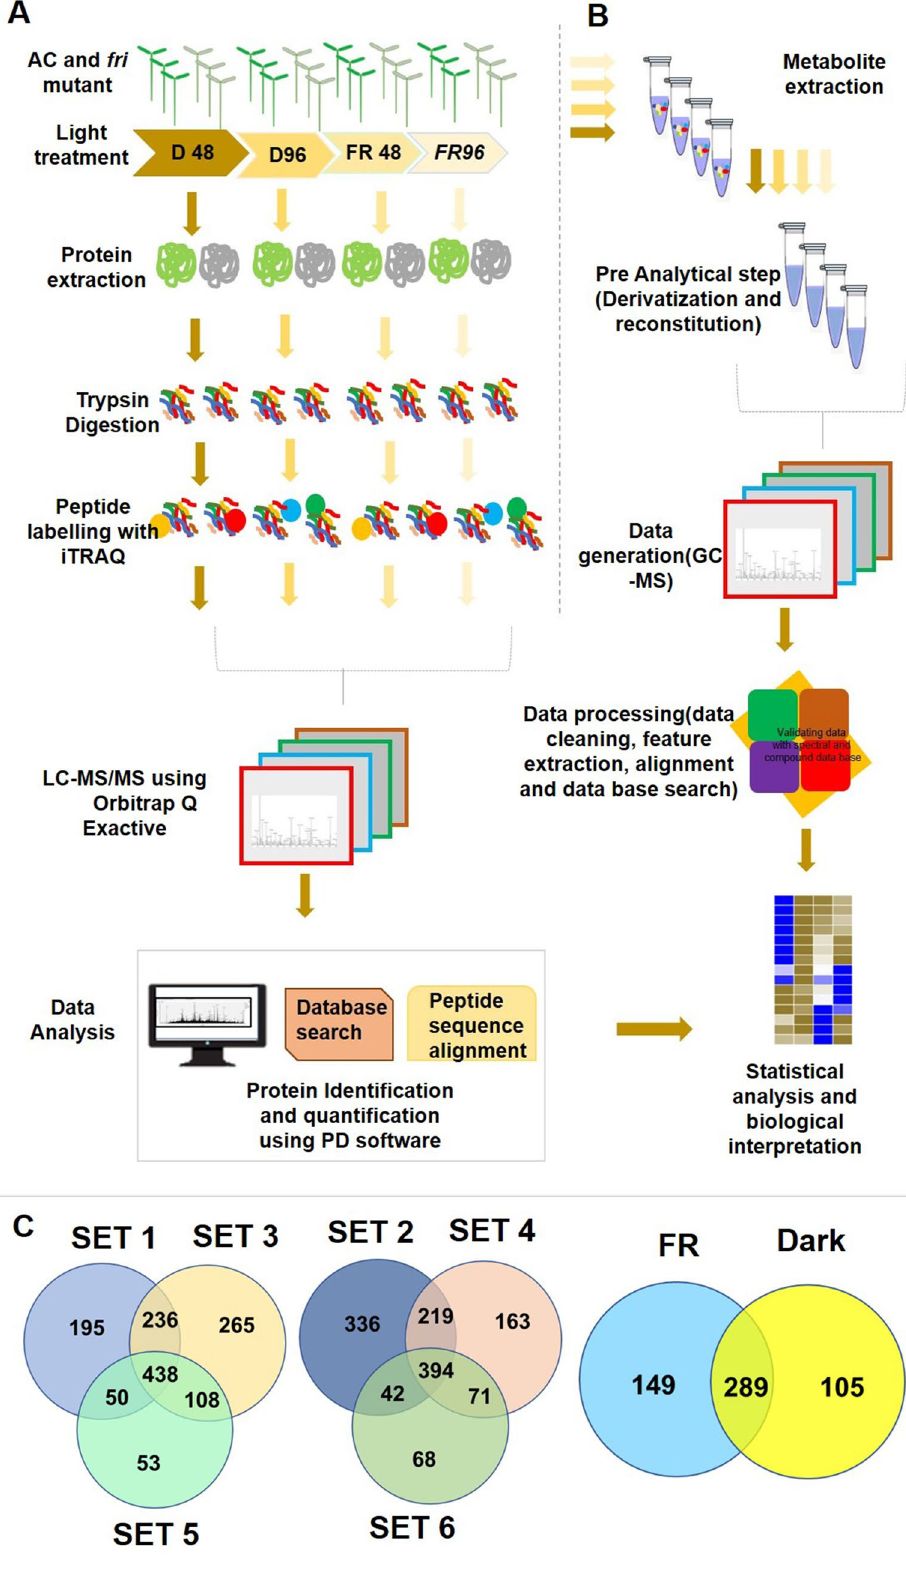
Figure 1. Quantitative proteomics and metabolite profiling of tomato seedlings to understand the role of PhyA in FR light-mediated photomorphogenesis. ( A ) Schematic illustration of the overall experimental strategy used in the discovery-phase global quantitative proteomics and metabolomics. ( B ) Venn diagram showing the unique and overlapping proteins identified in specific light treatment at two different time